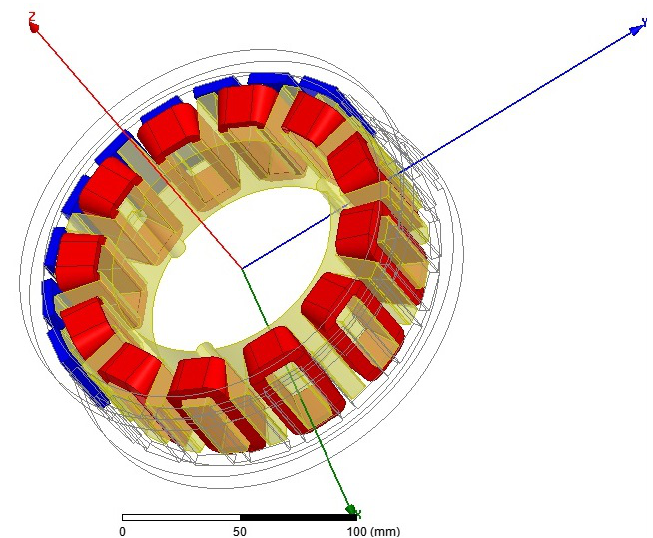
Figure 5. Adaptive mesh plot for magnetostatic analysis.